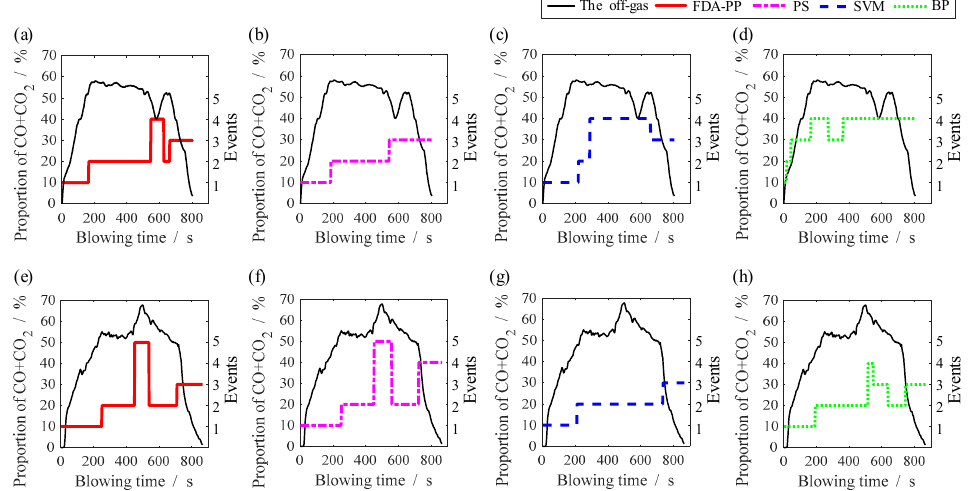
Figure 7. ( a – d ) Production state recognition of a splashing batch by different methods; ( e – h ) pro- duction state recognition of a drying batch by different methods. Here, the events indicate that: 1-the first blowing period, 2-the main blowing period, 3-the main blowing period, 4-the splashing anomaly, 5-the drying anomaly.